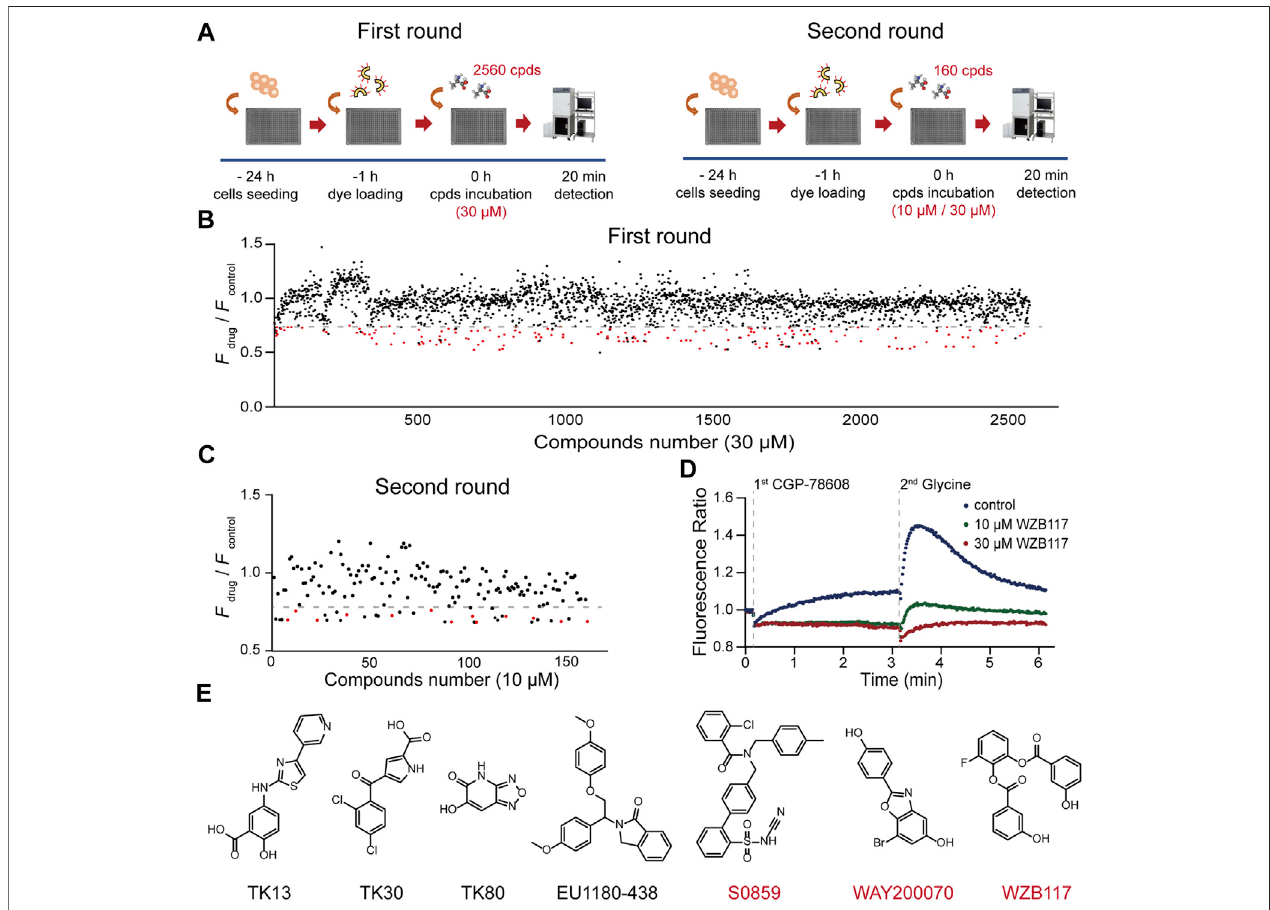
FIGURE 2 | HTS for GluN1/GluN3A modulators. (A) Flow chart of the HTS. (B) Overview of the fi rst round results. The Ca 2+ fl uorescence signal ratio ( F drug / F control ) ofallcompounds(2560)isrepresentedbyacircle.Compounds(30 μ M)witharatiolessthan0.75(thedashedline)wereconsideredasthepre-hitsandaredisplayedas redcircles.Datarepresentthemeanoftheduplicateresults. (C) Discoveryofhits.Atotalof160pre-hitswereselectedforthesecondround.Compounds(10 μ M)witha ratio less than 0.75 (the dashed line) and showing a dose-dependent inhibitory activity were considered as potent hits of GluN1/GluN3A receptors. (D) Representative fl uorescence signal of a hit in the FDSS/ μ Cell. The well-to-well variation was 0.01 at 10 μ M and 0.02 at 30 μ M (calculated with standard deviation). (E) Chemical structures of previously reported (black) and newly discovered (red) modulators.